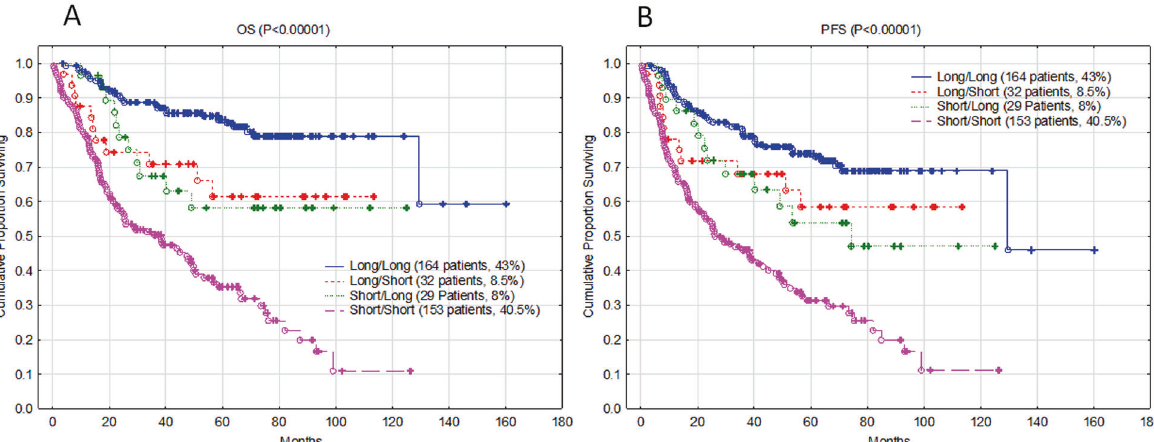
Fig. 2 Validation of the machine learning models used for survival grouping and selection of biomarkers. a Actual overall survival (OS) and b progression-free survival (PFS) of the four groups as predicted by the selected biomarkers.